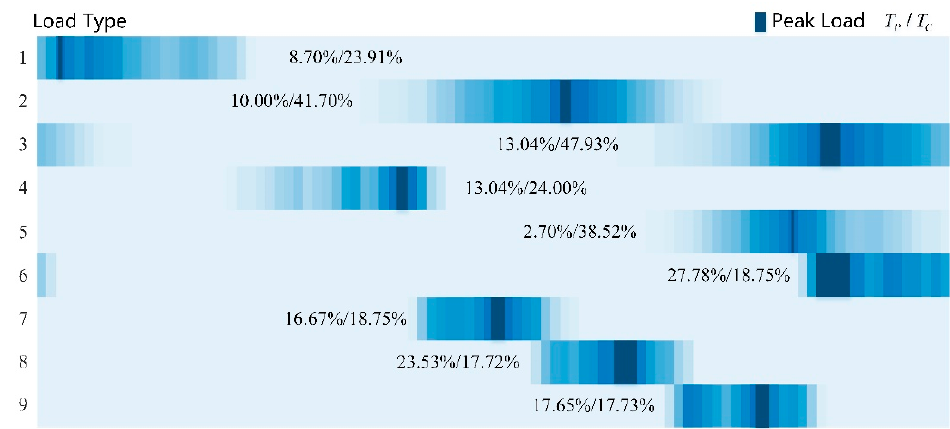
Figure 7. The box figure of each type of load.